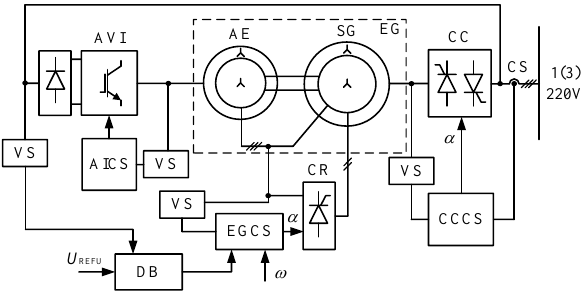
Figure 1. Functional diagram of stabilizing system of the electrical output voltage parameters by means of DC excitation winding circuit